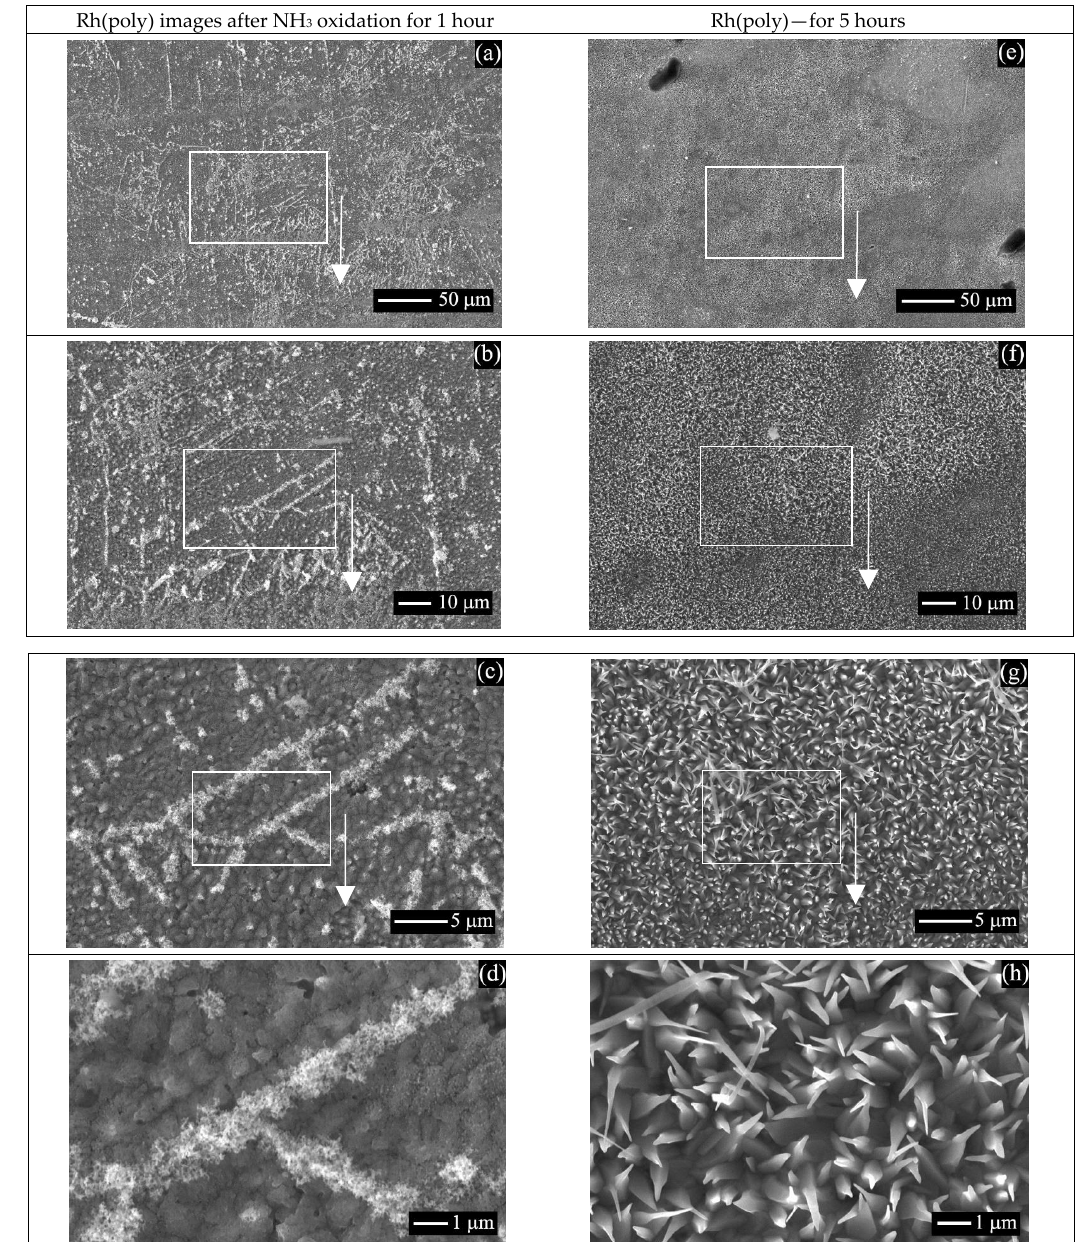
Figure 5. Concentrations of Pt, Rh and C, O, N on Pt(poly) ( a – c ) and Rh(poly) ( d – f ) after NH 3 oxi- dation at 1133 K for 1 ( a , d ), 5 ( b , e ) and 10 ( c , f ) hours according to EDS data obtained at a probe electron energy E 0 = 20 keV.